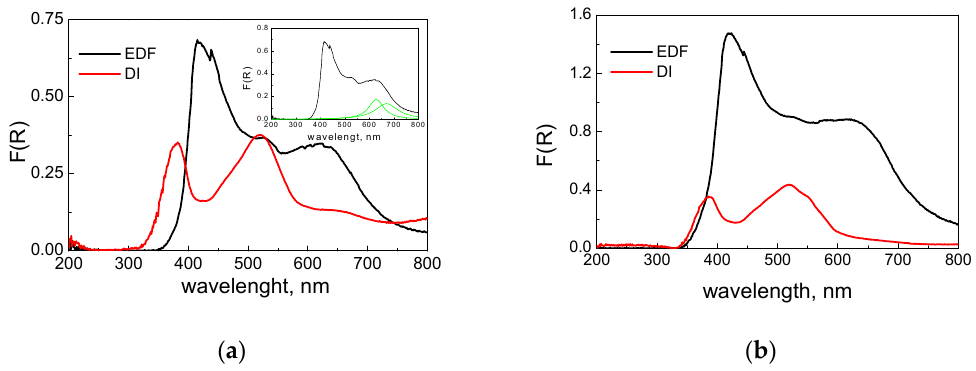
Figure 2. Diffuse reflectance spectra of wet ( a ) and dried ( b ) samples. Figure 2. Di ff use reflectance spectra of wet ( a ) and dried ( b )